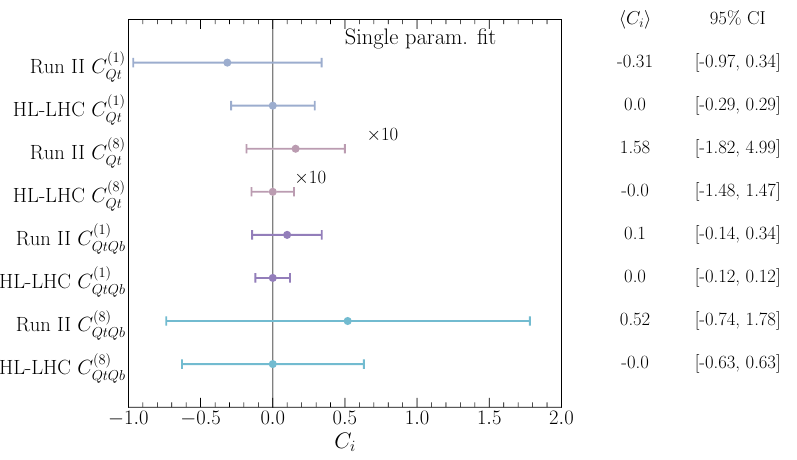
Figure 8 . Results of a single parameter fit showing the improvement in constraining power of the HL-LHC over the current bounds from Run-II data. The limits correspond to values of the Wilson coefficients evaluated at the scale Λ = 1 TeV.